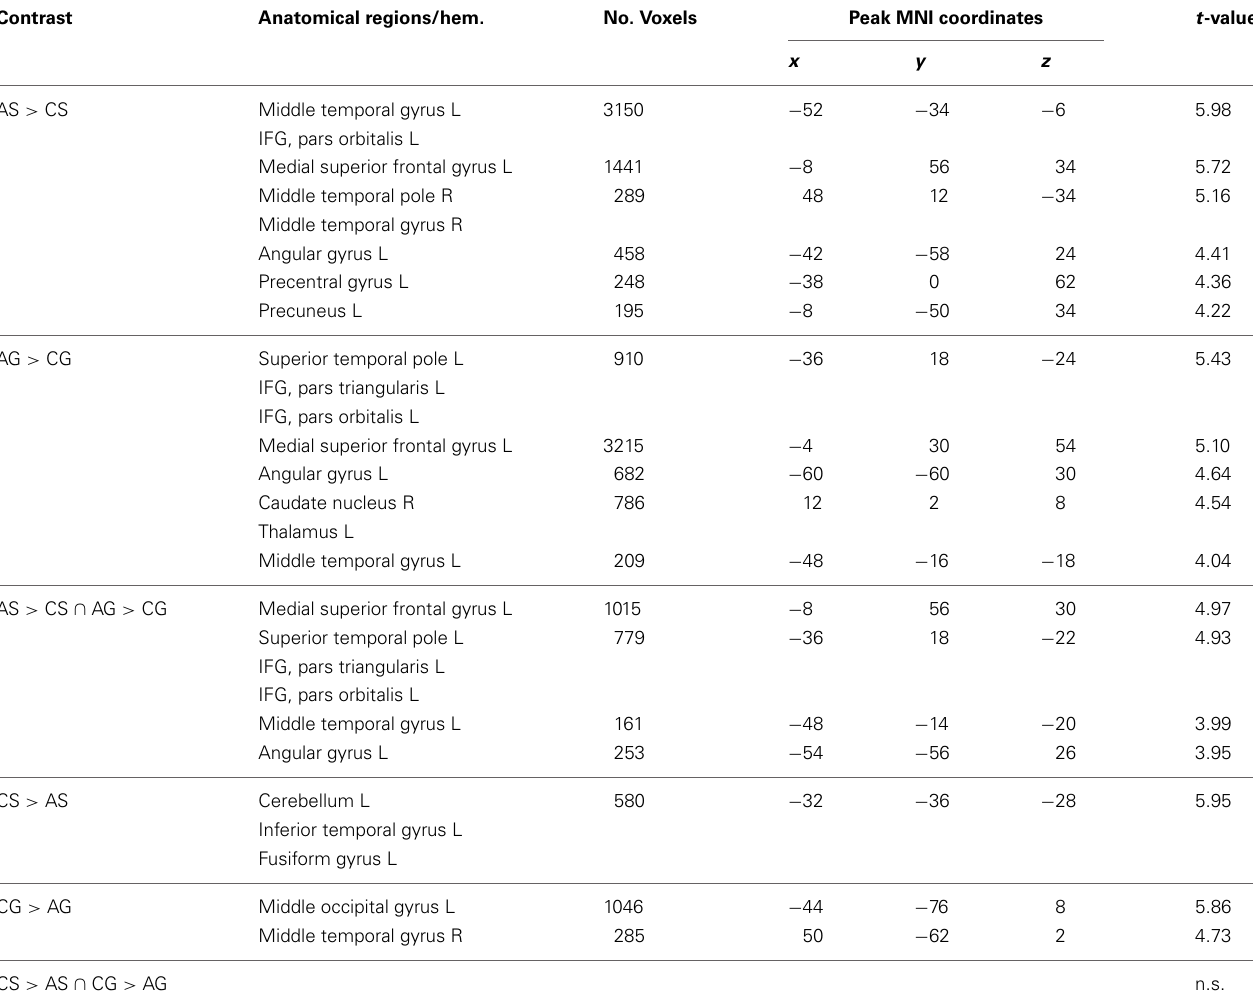
Table lists the respective contrast, anatomical regions, cluster size, MNI coordinates, and t-values for each significant activation (p < 0.05 corrected for